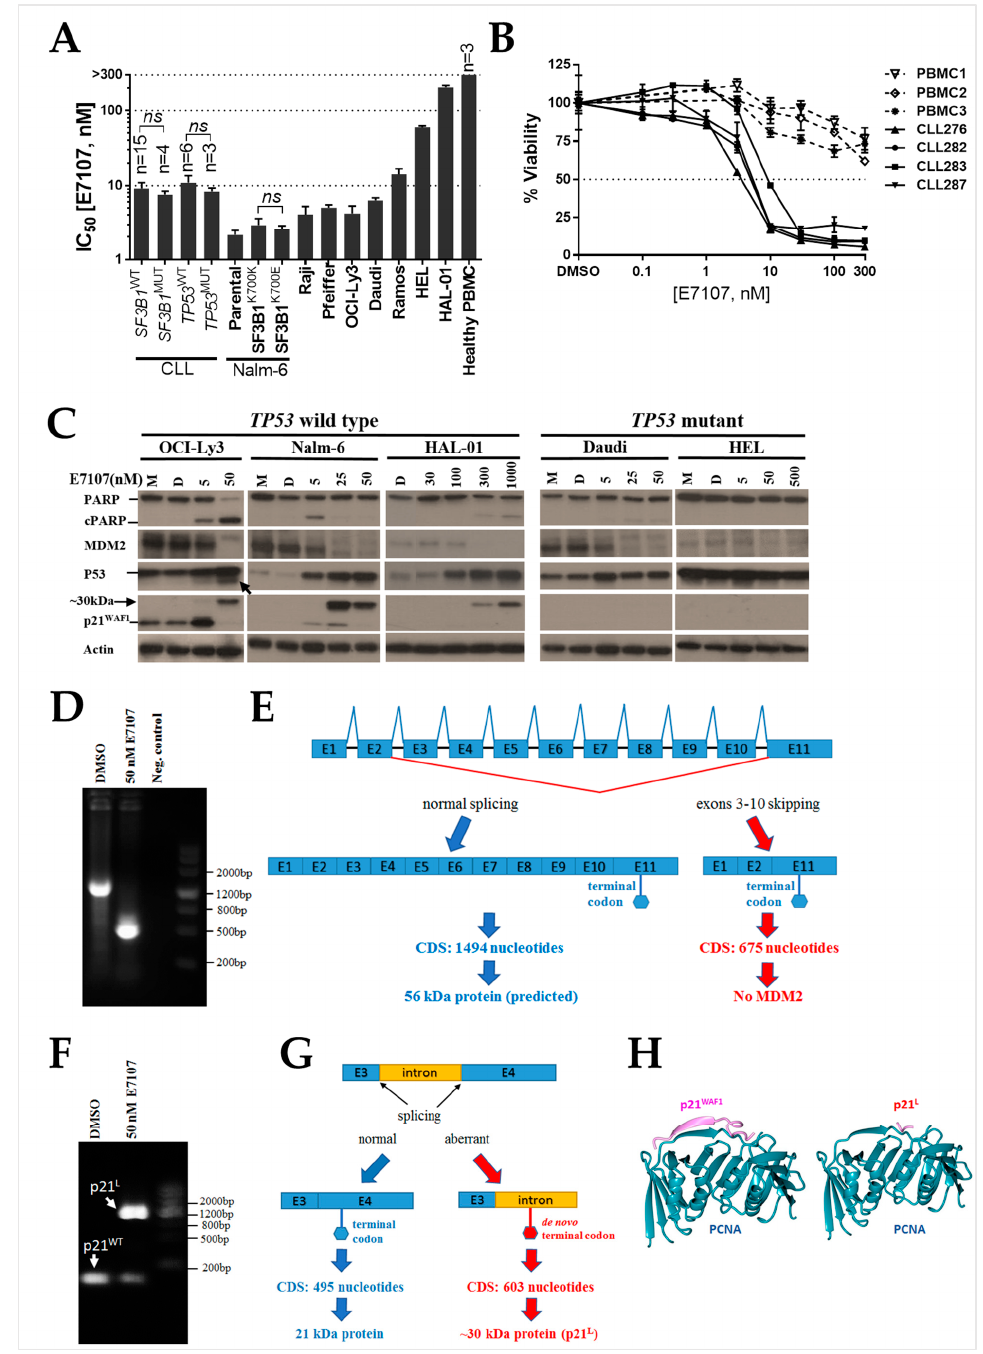
Figure 1. E7107 treatment resulted in aberrantly spliced transcripts and protein products of p53 pathway genes. ( A ) E7107 IC 50 values for 28 primary CLL patient samples of differing TP53 and SF3B1 status and a panel of cell lines, including otherwise isogenic paired SF3B1 mutant and wild‑type Nalm‑6 cells. Error bars for the cell lines show the mean ± standard error of the mean (SEM) of at least three independent repeats. ( B ) Dose‑dependent inhibition of cell viability using E7107 for four representative CLL primary samples and three PBMC samples from healthy indi‑ viduals. ( C ) Immunoblot of p53 and its transcriptional targets for TP53 WT OCI‑Ly3, Nalm‑6 and HAL‑01, and TP53 MUT Daudi and HEL cells treated with E7107 at concentrations indicated on the figure for 24 h. Actin was used as a loading control. M: No DMSO control cell lysate; D: DMSO solvent control‑treated cell lysate. The arrow below the p53 band for OCI‑Ly3 points to a